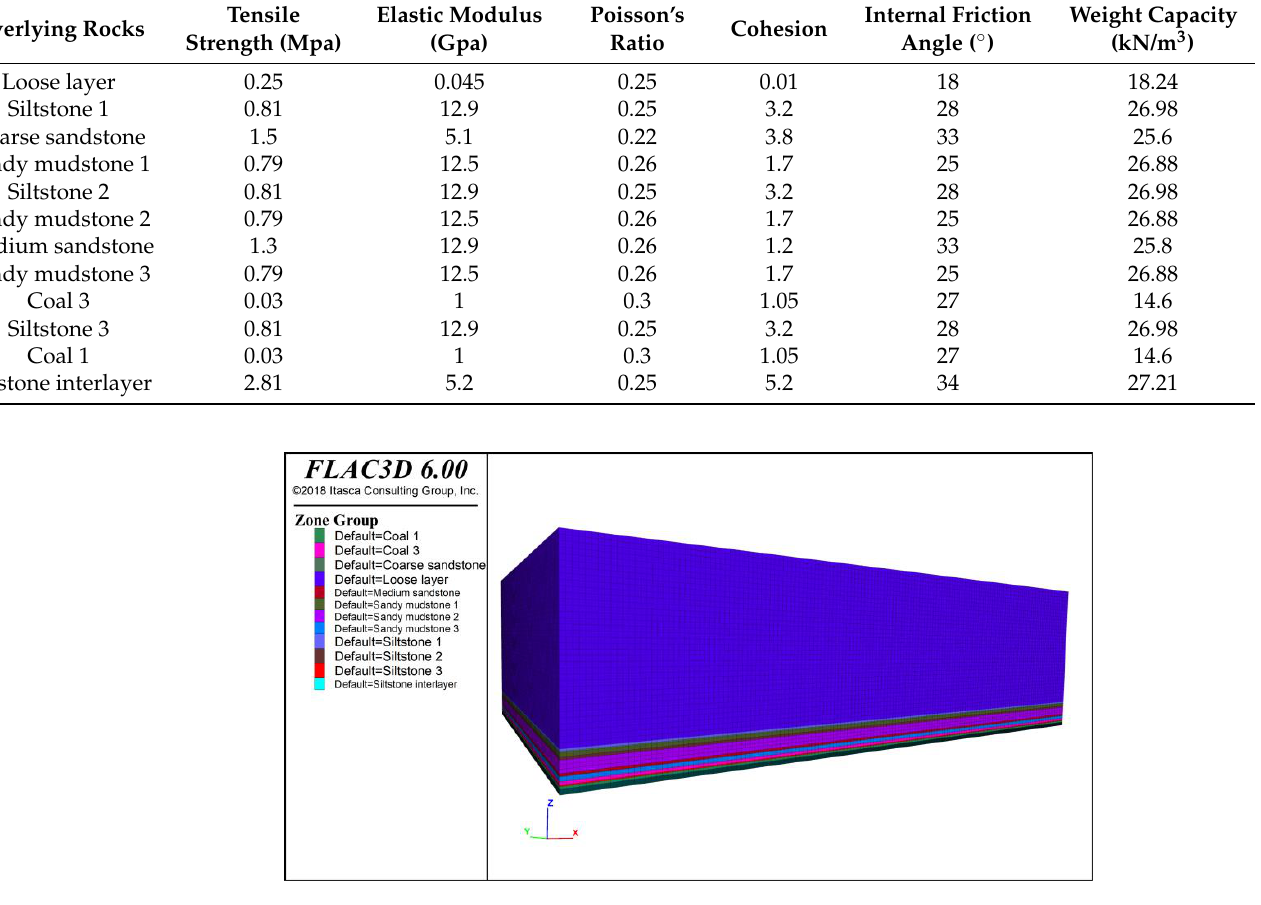
Figure 11. Numerical simulation model.